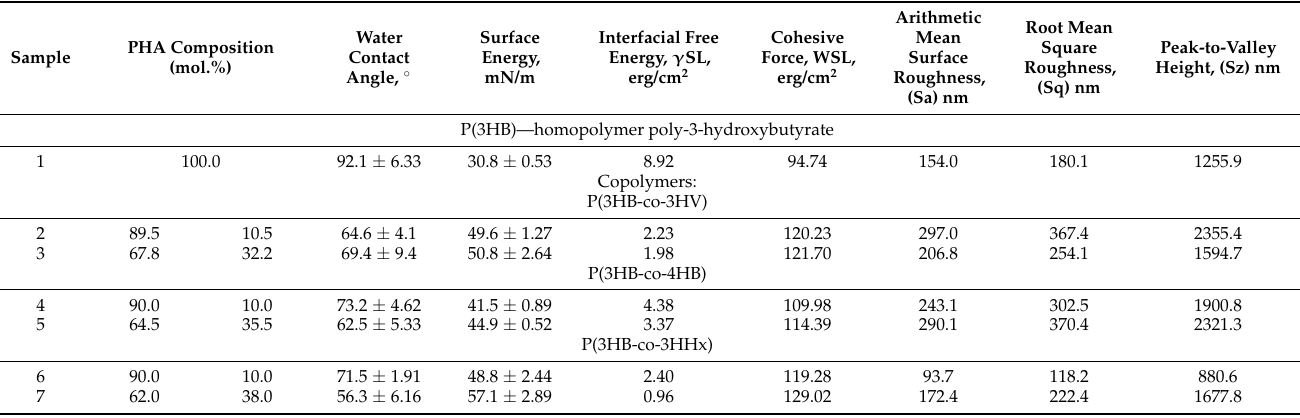
and reduced values of the contact angle of wetting with water (Figure 2, Table 2).